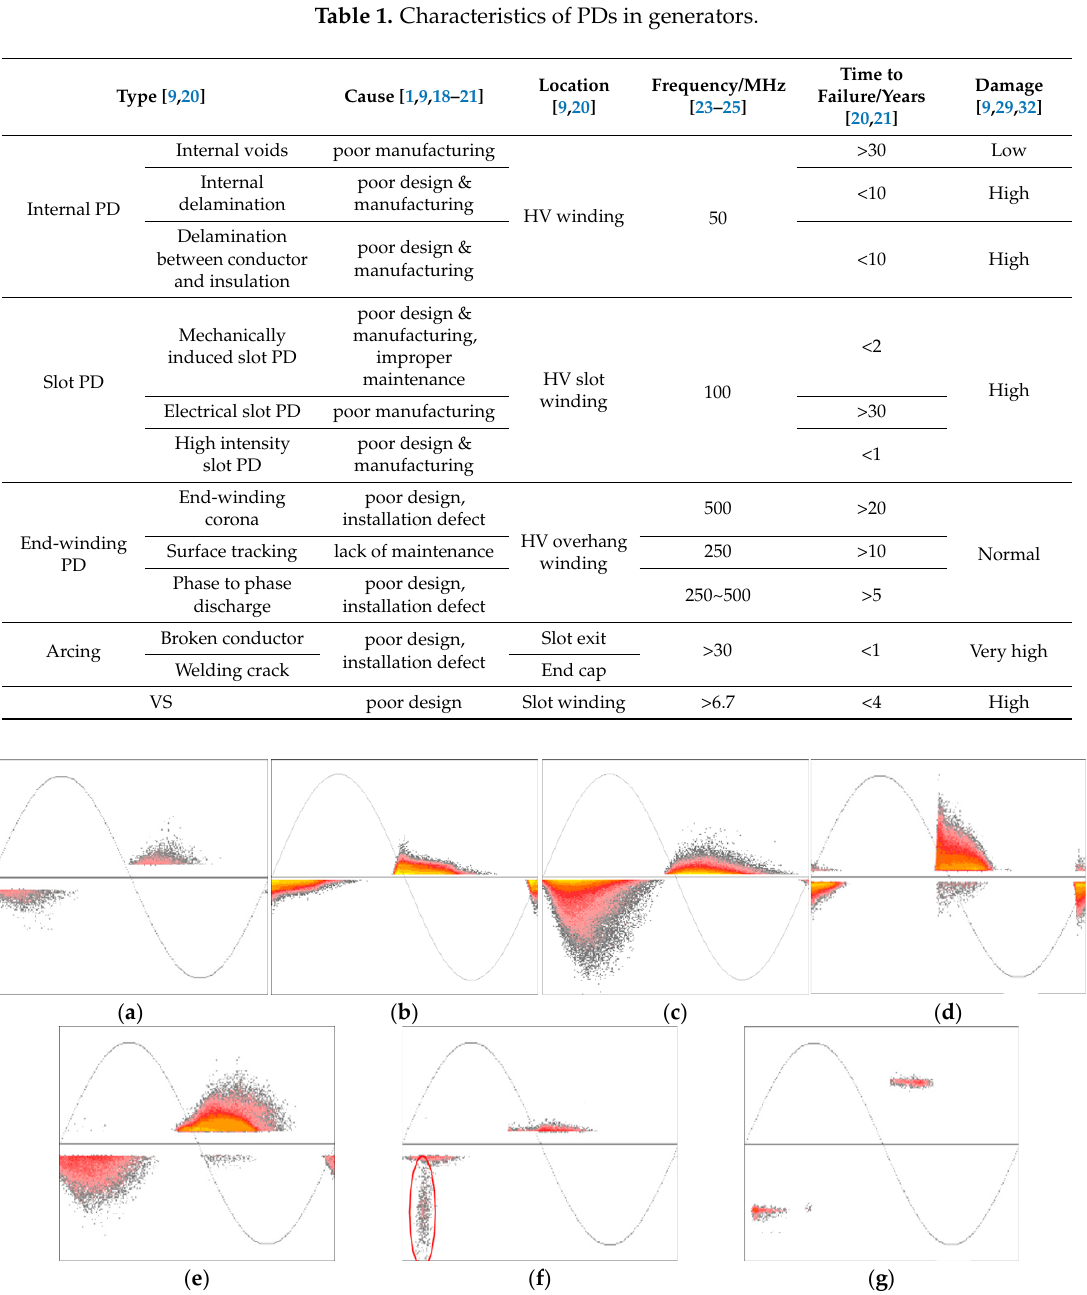
Figure 3. PD patterns in [9,23] ( a ) Internal voids; ( b ) Internal delamination; ( c ) Delamination between conductor and insulation; ( d ) Slot discharge; ( e ) End-winding corona; ( f ) Surface tracking; ( g ) Phase to phase discharge.